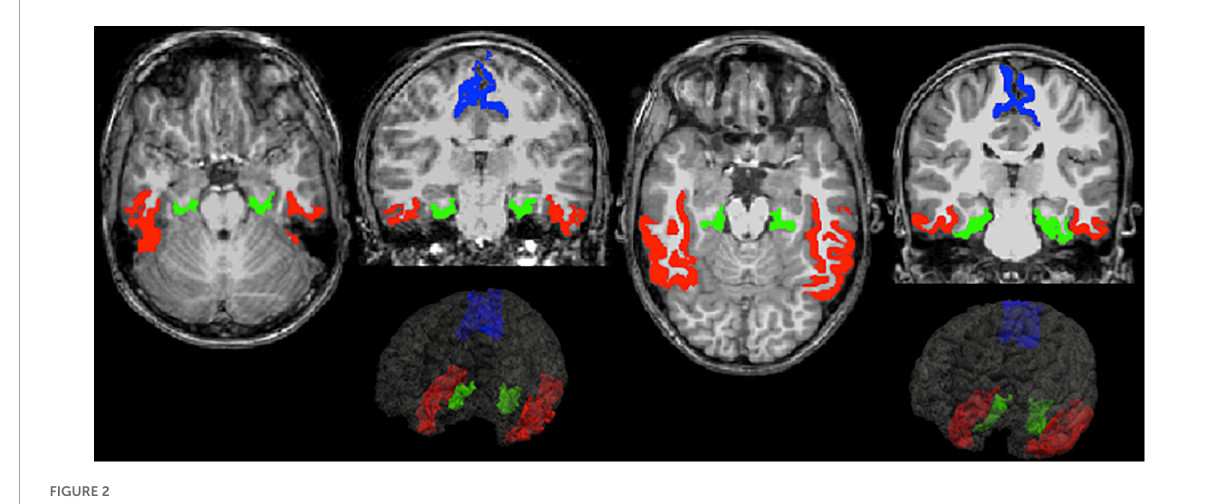
FIGURE2 Example figures of inferior temporal (red), parahippocampal (green), and postcentral (blue) regions where differences were found between exposed (left) and unexposed (right) group of adolescents born very preterm in transaxial and coronal slices of T1-weighted magnetic resonance imaging (MRI)